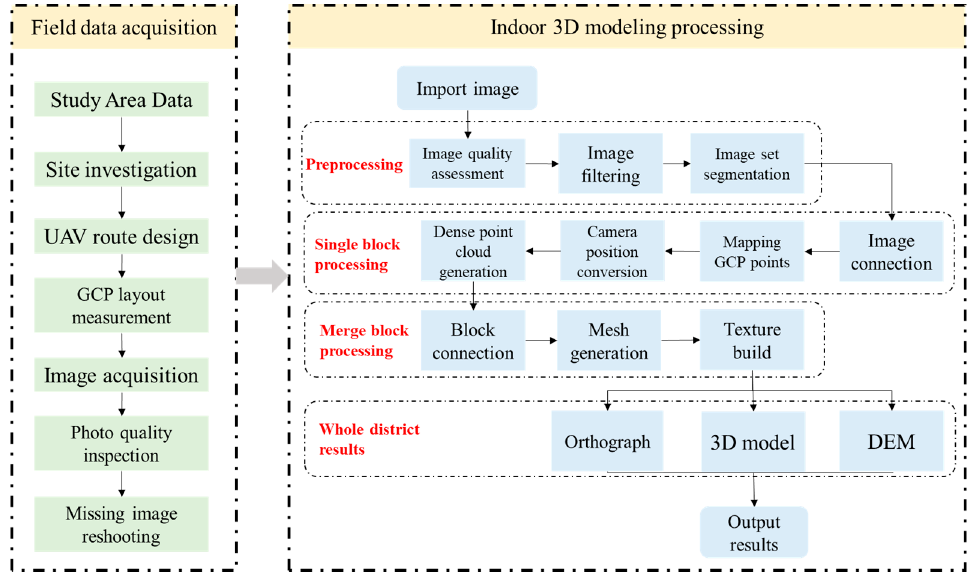
Figure 3. Workflow for UAV 3D modeling.